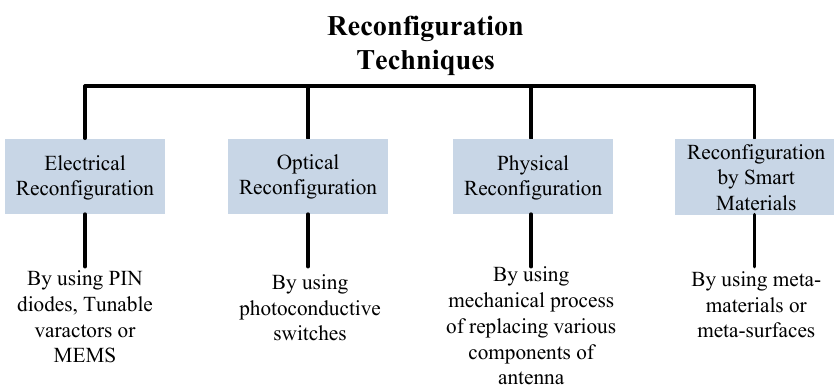
Figure 11. Various techniques adopted to obtain